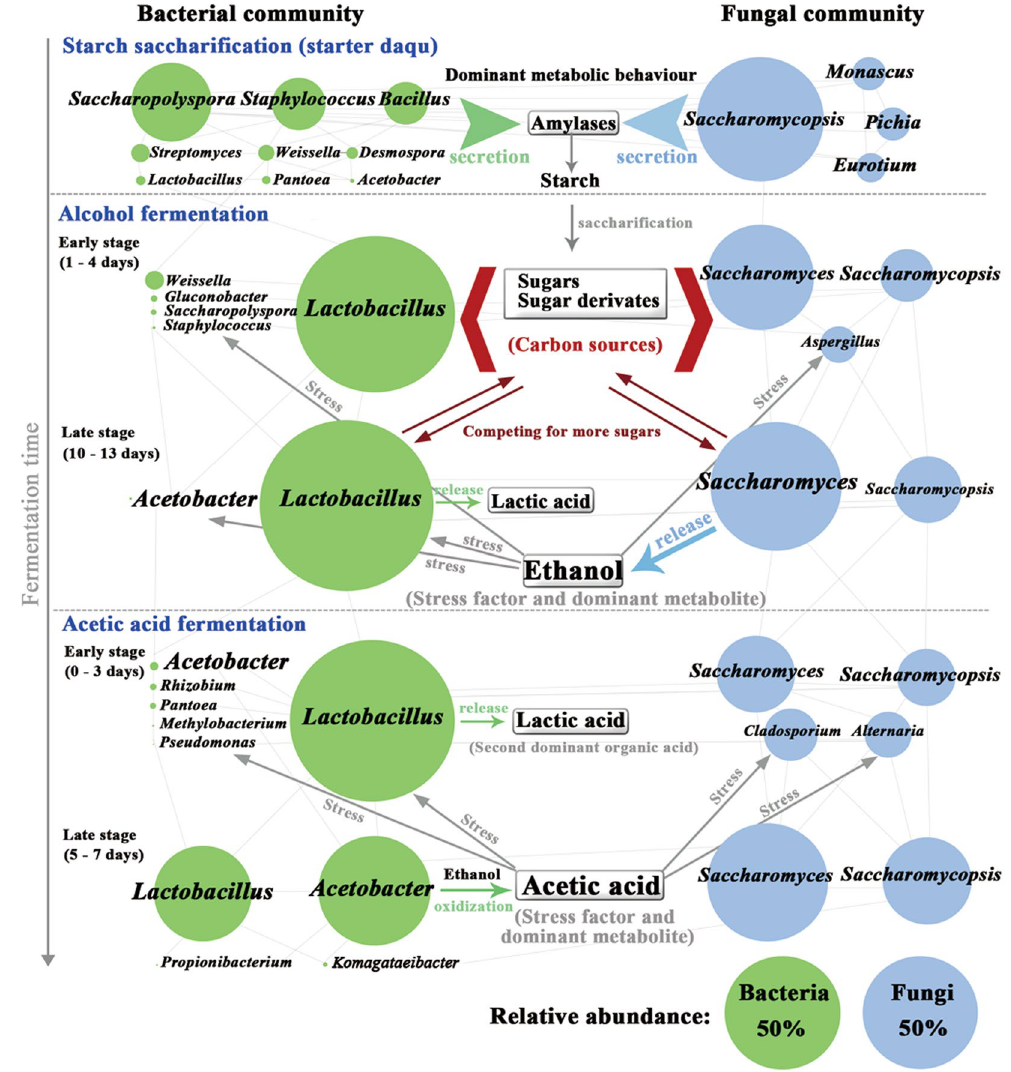
Figure 6. Schematic overview of the correlations between microbiota succession and nonvolatile metabolites in different SAV fermentation stages. The whole fermentation process is divided into five typical fermentation stages, including starch saccharification, alcohol fermentation (early stage and late stage), and acetic acid fermentation (early stage and late stage). The green circle represents the predominant bacteria, and the blue circle represents the predominant fungi. The area of each circle represents the relative abundances of each microorganism. The relative abundances of the circle area are listed in the bottom right. Arrows and lines represent the correlations between metabolites and microorganisms. The word “stress” represents the inhibition of different metabolites on microbial growth. The word “release” represents the secretion of metabolites from